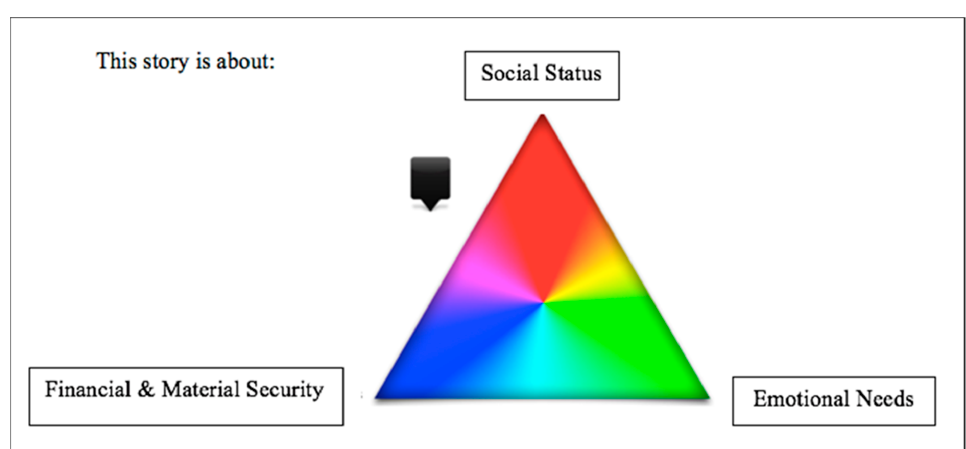
Figure A1. Example triad question.